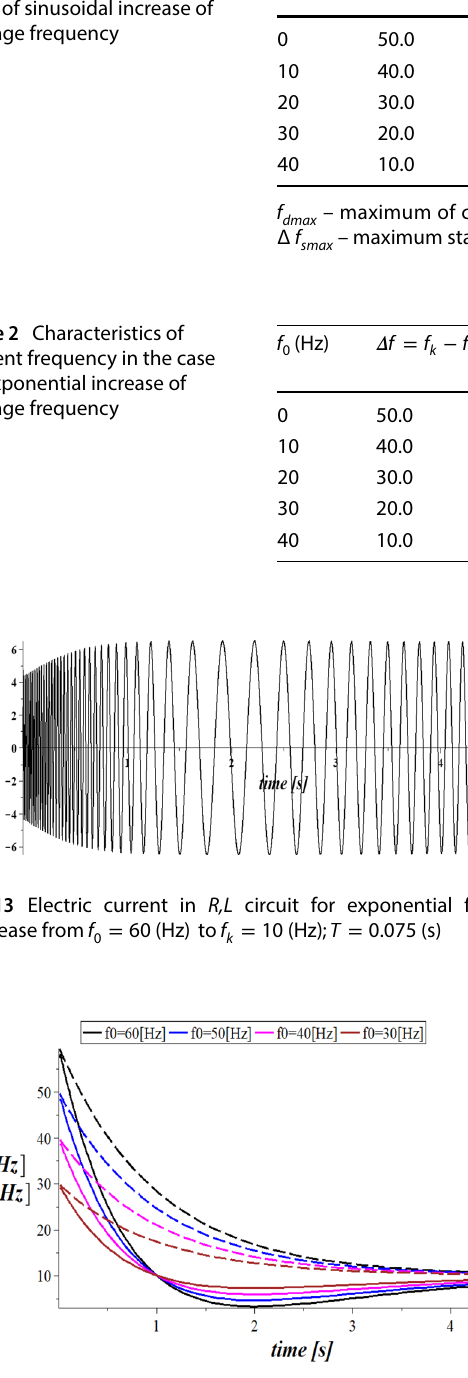
Table 1 Characteristics of current frequency in the case of sinusoidal increase of voltage frequency